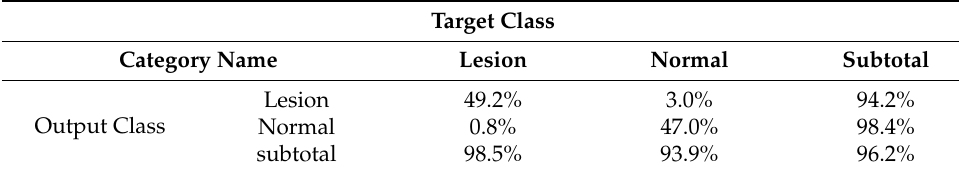
Table 7. The confusion matrix of AlexNet training result.